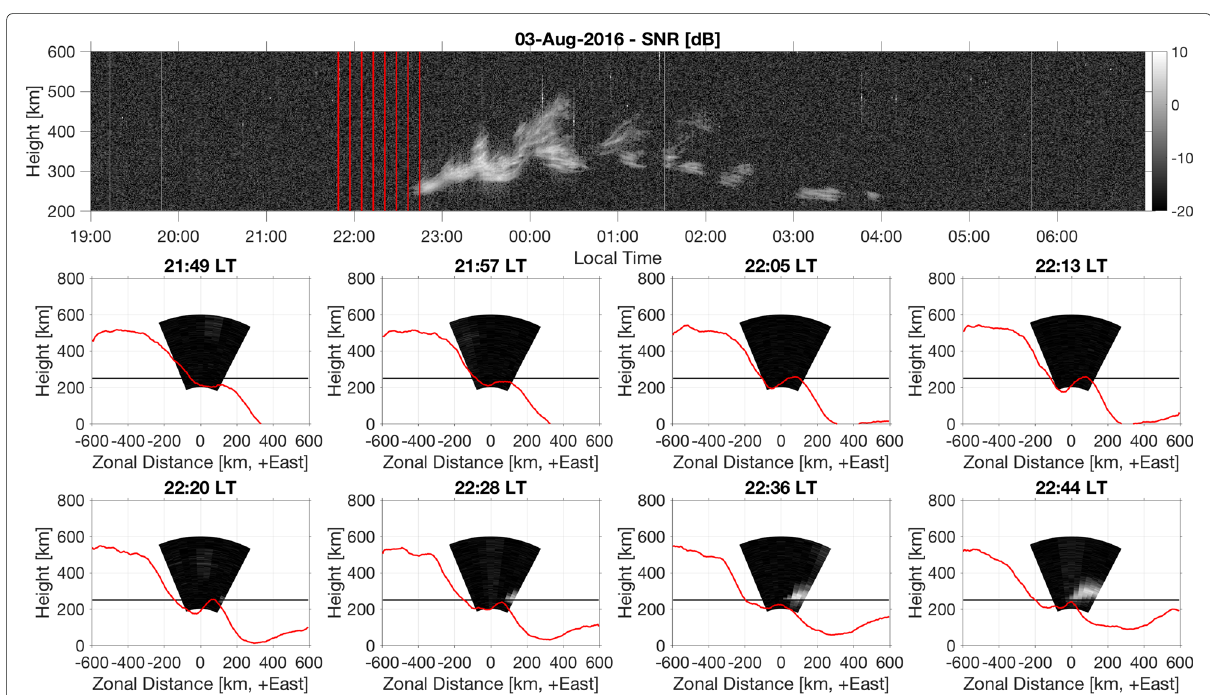
Fig. 7 Comparison of airglow intensity and echo occurrence. The top panel shows the RTI maps for August 3–4, 2016. The bottom panels show the spatial distribution of echoes observed by AMISR-14 in the magnetic equatorial plane. The times are indicated by the vertical lines in the RTI map and on top of each panel. The bottom panels also show the variation of the airglow intensity (630 nm) as a function of zonal distance (red solid line)